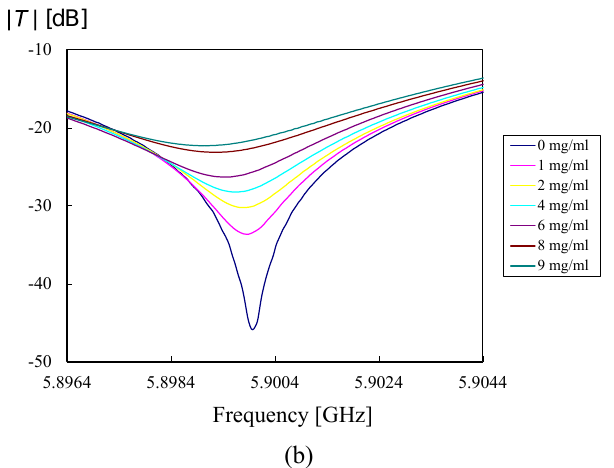
Figure 5: Measured transmission coefficient magnitude T for different NaCl concentrations: (a) at test frequency of 2 GHz, (b) at test frequency of 5.9 GHz.